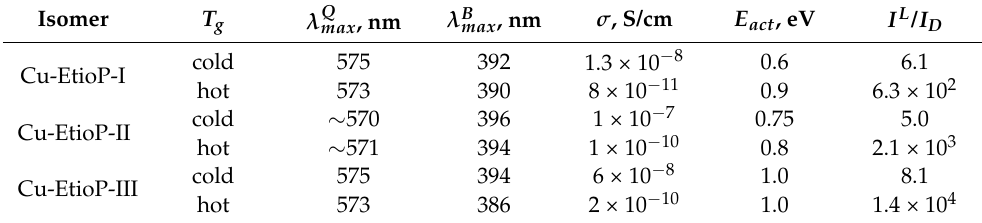
Table 1. Some parameters of copper etioporphyrin isomers in thin films.